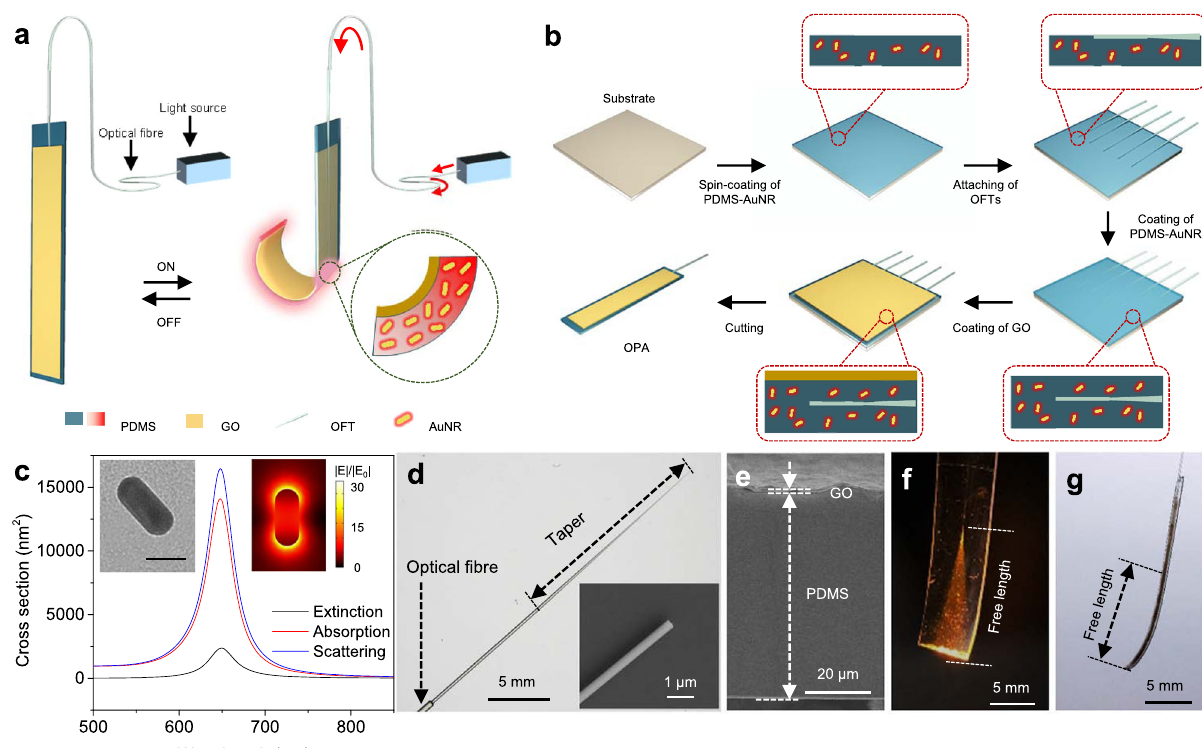
Fig. 1 Structure, mechanism and fabrication of OPAs. a Schematic of the structure and driving mechanism of the OPA. b Preparation process of OPAs. c Calculated extinction, absorption and scattering cross section of an AuNR. The insets present a transmission electron microscope image of an AuNR (left) and a calculated near- fi eld distribution of an AuNR at the wavelength of 638 nm (right). Scale bar: 30 nm. Source data are provided as a Source Data fi le. d Optical microscope image of an OFT with a taper length of ~1.75 cm. The inset presents a scanning electron microscopy image of the tip of the OFT showing a diameter of ~700 nm. e Cross-sectional view of the PDMS-GO fi lm. The thicknesses of PDMS and GO layer are ~70 and 1.5 μ m, respectively. f Photograph of sending 635 nm light into an OPA with a broadened width to show the light propagation path. g Photograph of an OPA with a typical size of ~500 μ m in width and ~1 cm in free